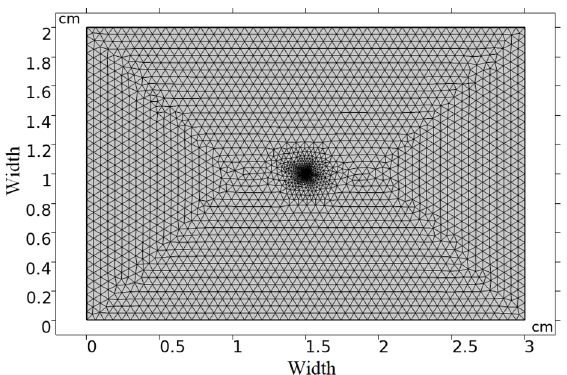
Figure 6. Finite element mesh and geometry for the fluence rate determination.